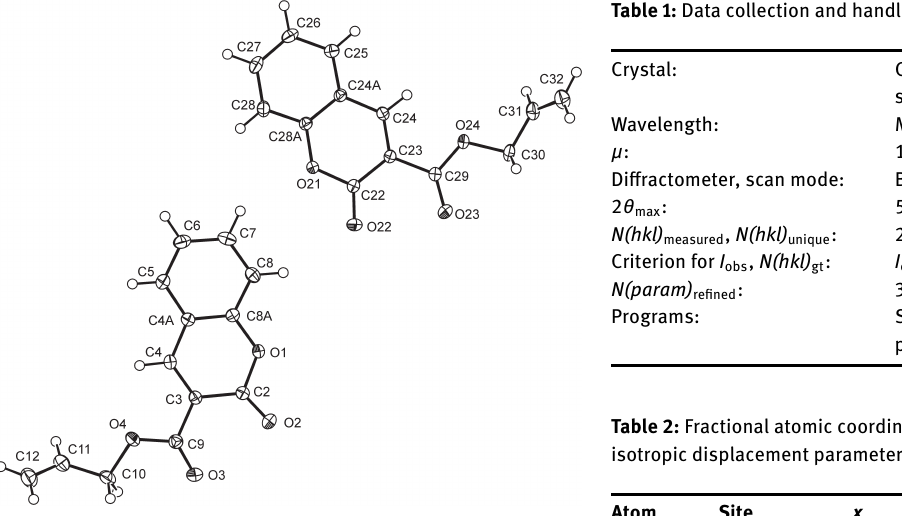
Table 1: Data collection and handling.